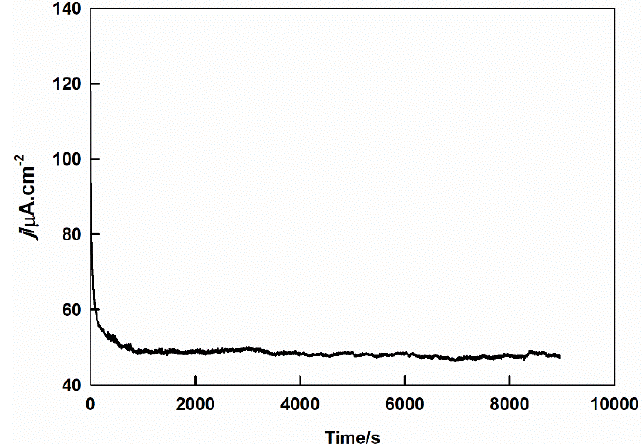
Figure 5. The current-time response of the potentiostatic experiment of GC/Sr 2 PdO 3 in 0.1 M HClO 4 subjected to a potential of 0.5 V for 150 min.